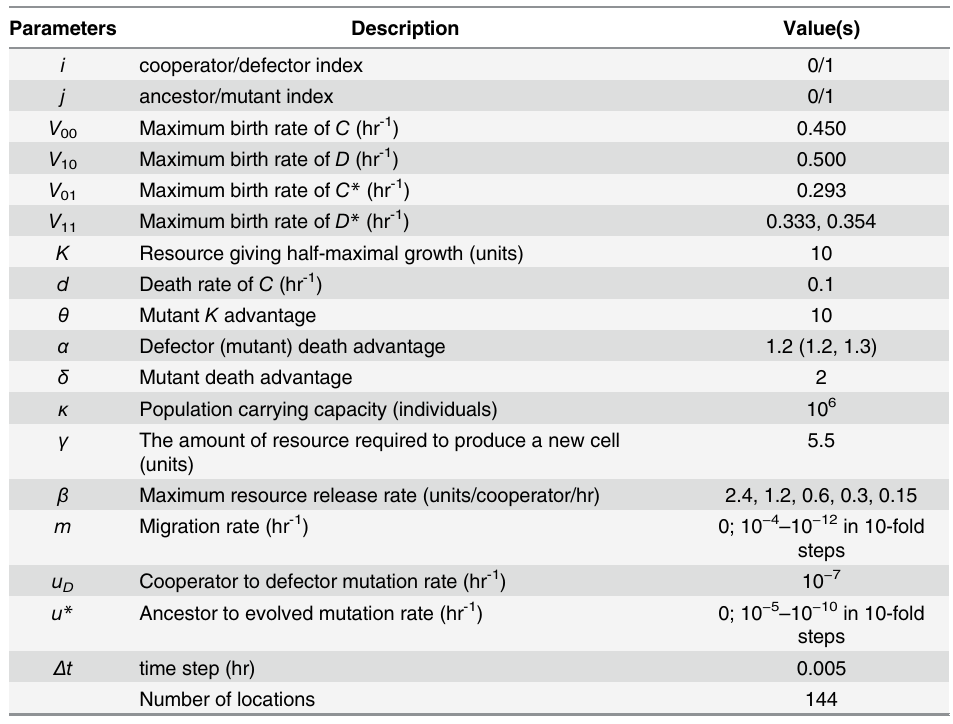
Table 1. Parameter